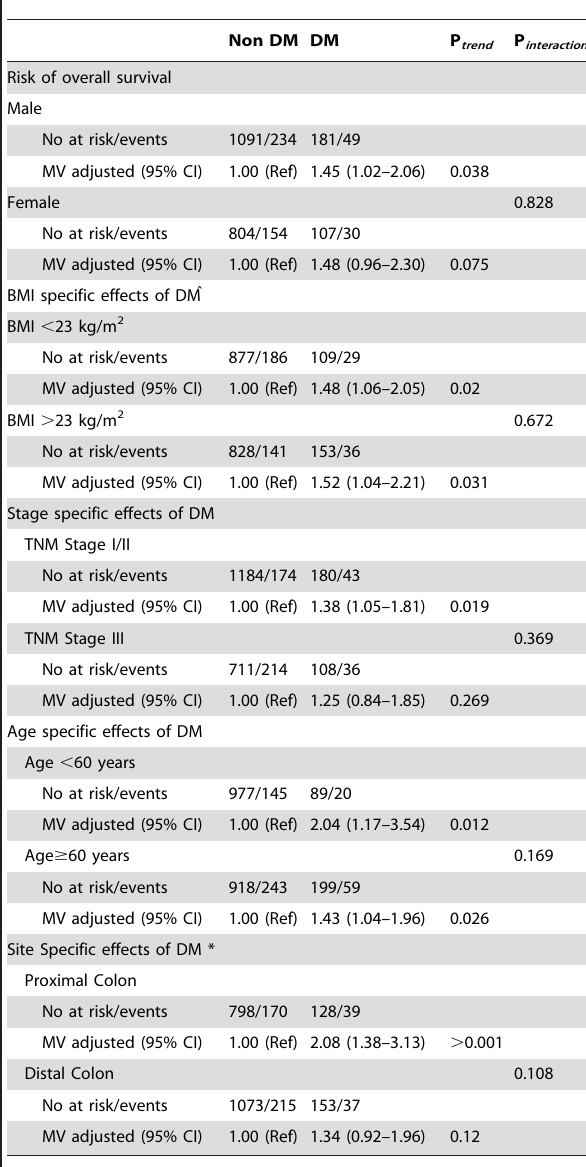
Table 3. Impact of DM on outcome of overall survival of stage 1 to 3 colon cancer patients according to their BMI, TNM stage, age and site of cancer (proximal vs